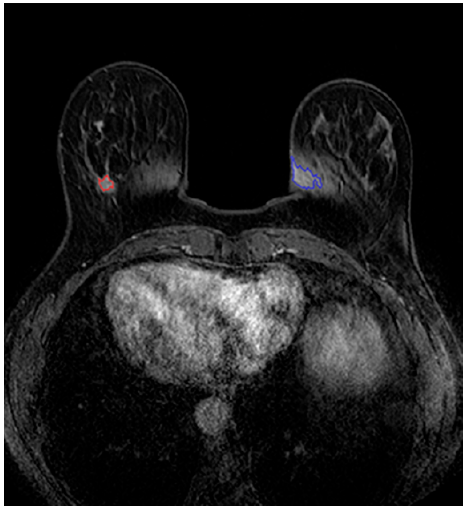
Figure 3. A typical result obtained by the CAD system. The objects found after the iterative procedure based on intensity values (ROI hunting) and the results of the classification prediction (red for tumor and blue for FP).